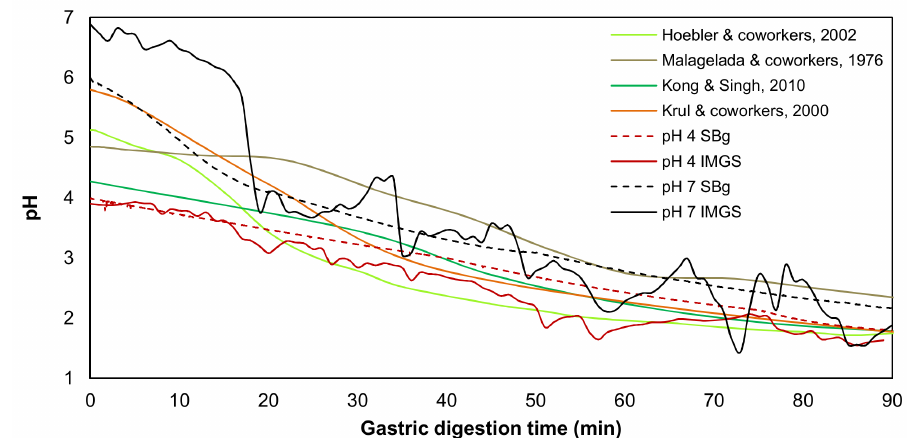
Figure 1. Variation of gastric pH during the in vitro digestion in the IMGS and in a stirred beaker (SBg) of the emulsion gels stabilized by whey protein isolate (WPI), in comparison with the literature